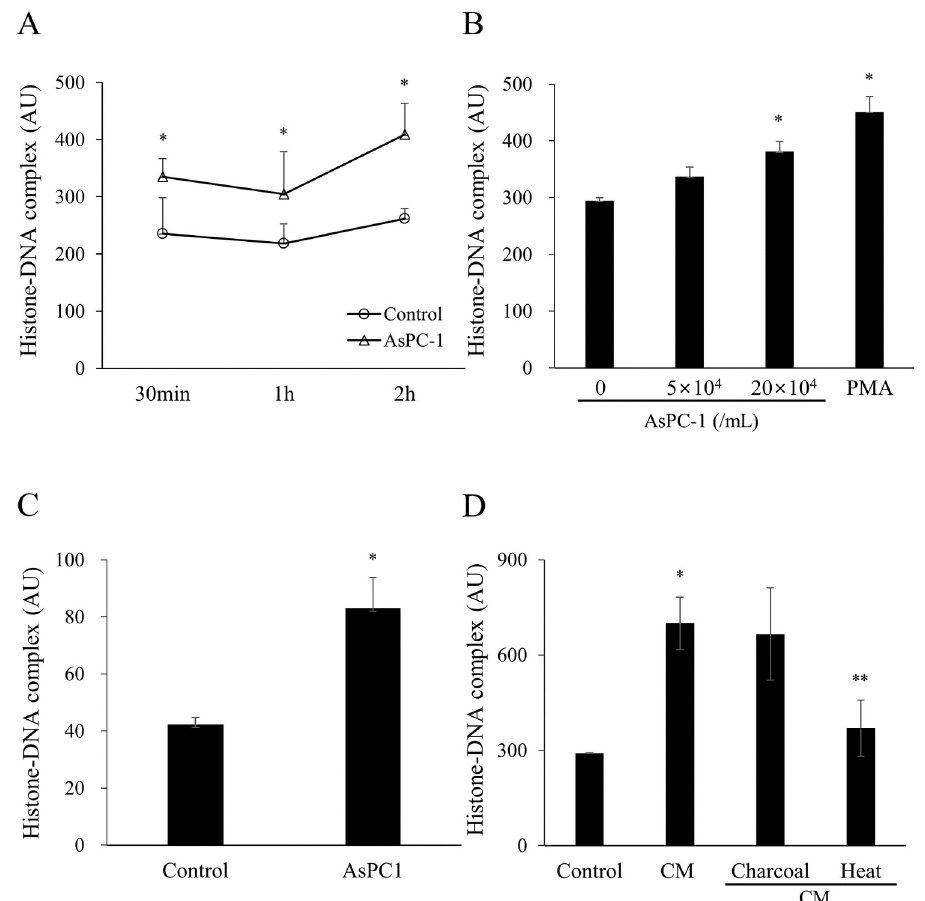
Fig 1. Pancreatic cancer cells AsPC-1 induce neutrophil extracellular traps. (A) AsPC-1 (5 × 10 4 cells/mL) were incubated with whole blood for 30 min, 1 h, or 2 h at 37˚C. Control represents whole blood without AsPC-1. The histone–DNA complex levels were measured in the supernatants. A significant difference was observed among the groups in histone-DNA complex level (NET formation) during incubation time. Statistical analysis was performed by two-way ANOVA followed by Bonferroni’s post-hoc test. � P < 0.05 versus control group. (B) AsPC-1 (5 × 10 4 or 20 × 10 4 cells/mL) were incubated with whole blood for 2 h. Phorbol 12-myristate-13-acetate (PMA, 25 nM) was used as a positive control of NET formation. Statistical analysis was performed by one-way ANOVA followed by Bonferroni’s post-hoc test. � P < 0.05 versus whole blood without AsPC-1. (C) AsPC-1 cells were incubated with isolated neutrophils for 2 h and the histone–DNA complex level was measured in the supernatants. (D) Conditioned medium (CM) harvested from AsPC-1 culture was incubated with whole blood for 2h and the histone-DNA complex level was measured in the supernatants. Charcoal was added to CM to remove lipids and heat treatment was used to degrade proteins. Data are expressed as mean ± SEM of 3 experiments. � P < 0.05 versus control; �� P < 0.05 versus CM. Abbreviations: AU, arbitrary